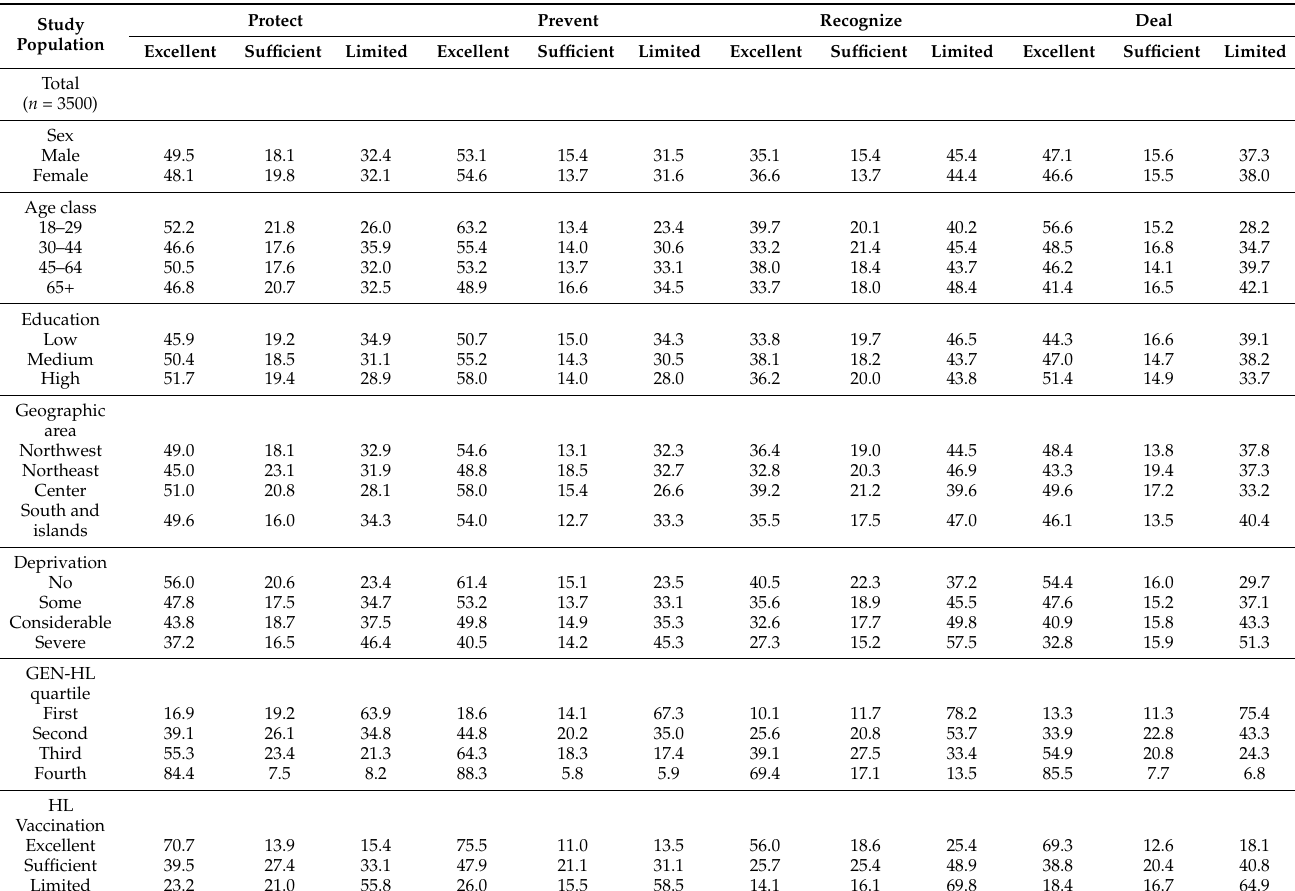
Table 4. HL-COVID levels of thematic subdimensions by participant